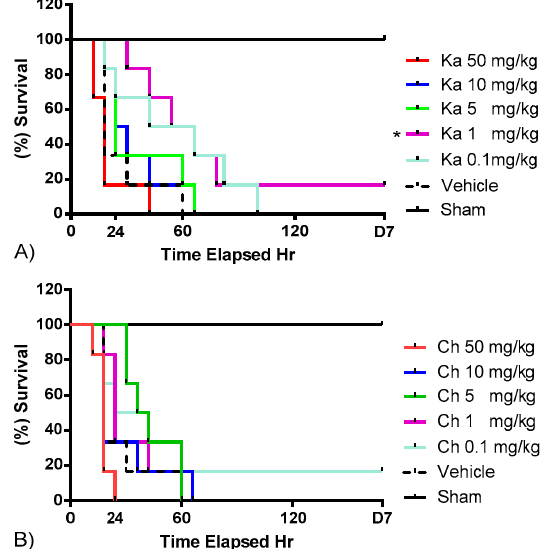
Figure 1. Kaplan–Meier plots of the survival rates (%) of cecal ligation and puncture (CLP)-challenged septic ICR mice treated with different doses of ( A ) kaempferol; ( B ) chrysin within 7 days. Animals were i.p. injected with treatments or vehicle (10 mL/kg) 1 h prior to CLP challenge, * p = 0.01.